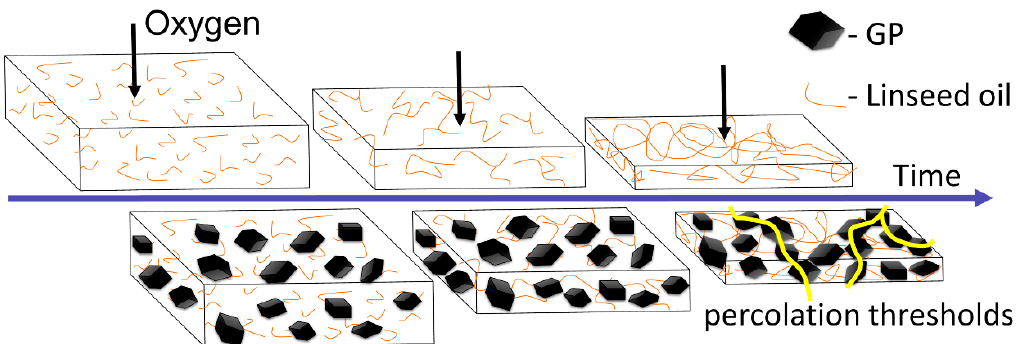
Figure 2. Schematic representation of the oil shrinkage mechanisms. Upper and lower panels depict